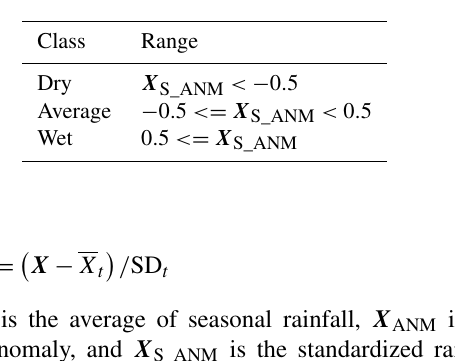
Table 1. Rainfall anomaly